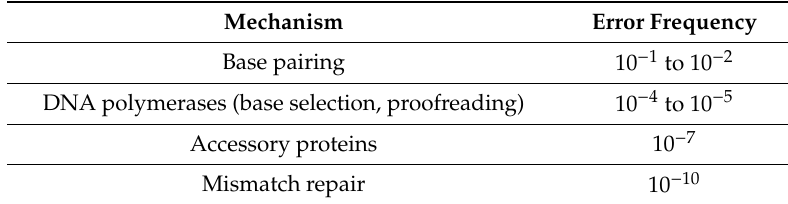
Table 1. The DNA error frequencies during the replication. The mismatch repair system (MMR) appears important in ensuring the DNA replication fidelity